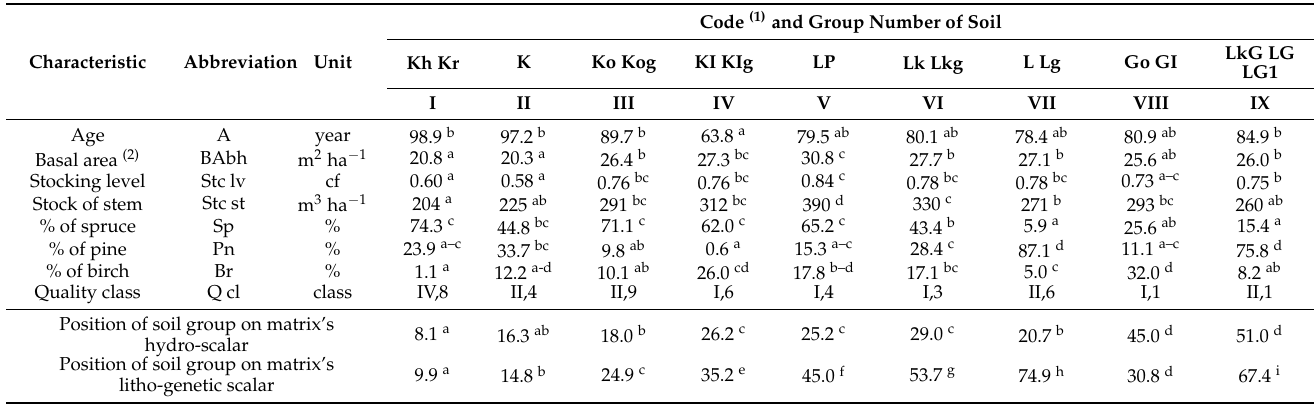
Table 2. Results of research areas’ stand taxation (inventory) ( n =